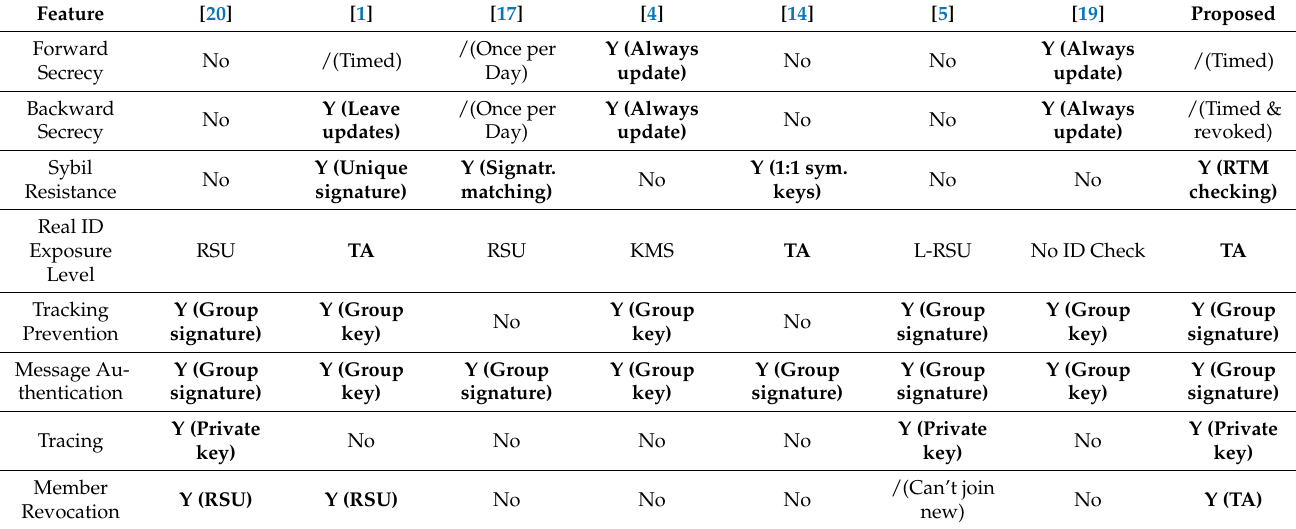
Table 2. Comparison of proposed scheme to existing group schemes. Y = provided, / = partially provided, N/A = not